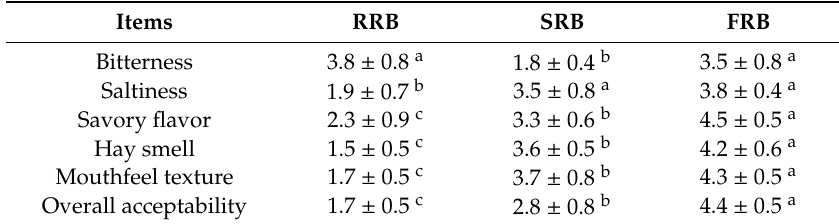
Table 5. Sensory evaluation of fermented rice